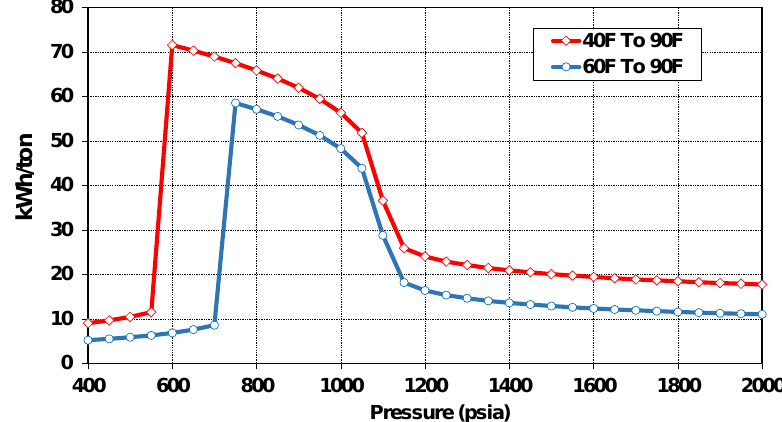
Figure 17. Energy required (kWh/ton) to heat CO 2 versus pressure from two temperature-change scenarios: 40 ◦ F to 90 ◦ F and 60 ◦ F to 90 ◦